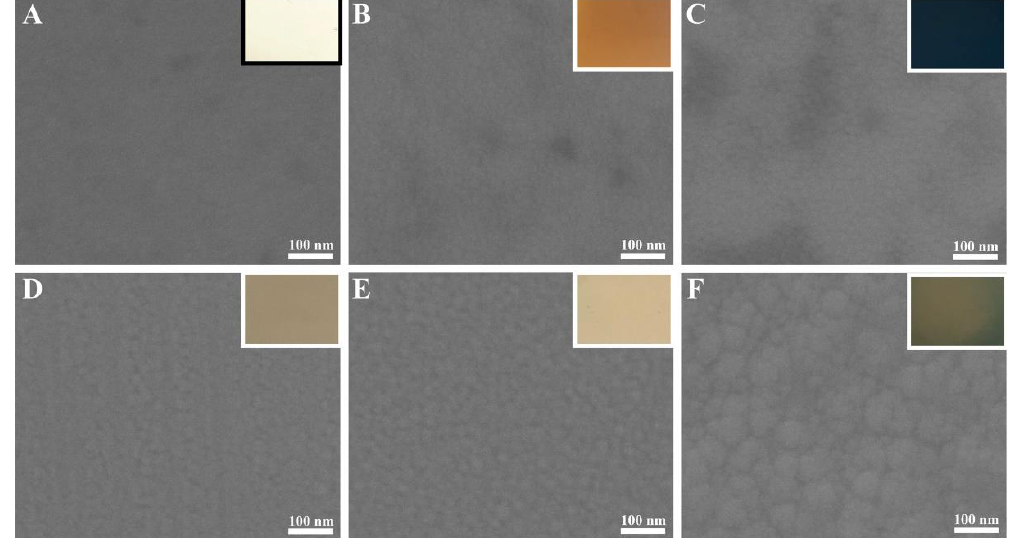
Figure 3. SEM images of Ag 10 nm/TiS 2 (t nm) nanostructures on Si wafers. ( A ) 2, ( B ) 5, ( C ) 10, ( D ) 20, ( E ) 30, and ( F ) 60 nm. The insets are the optical photos.